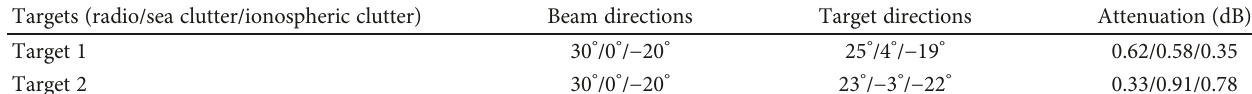
Table 7: Injected target parameters.